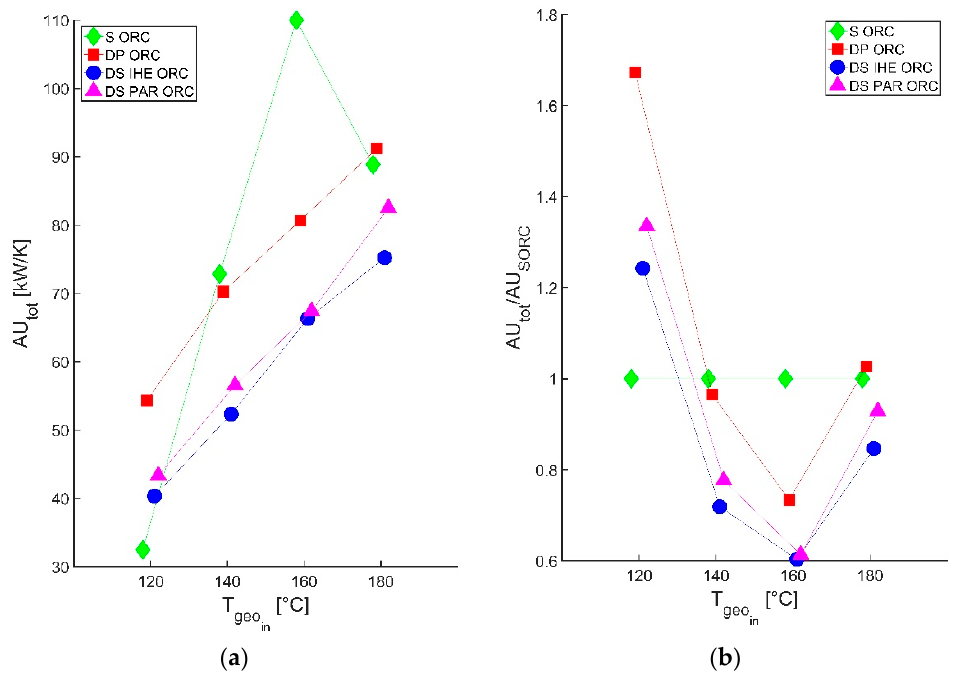
Figure 11. ( a ) The comparison of AU tot values of individual ORC configurations with the SORC configuration values, at different geothermal fluid temperatures; ( b ) the comparison of AU tot /AU tot-SORC values for the considered configurations.